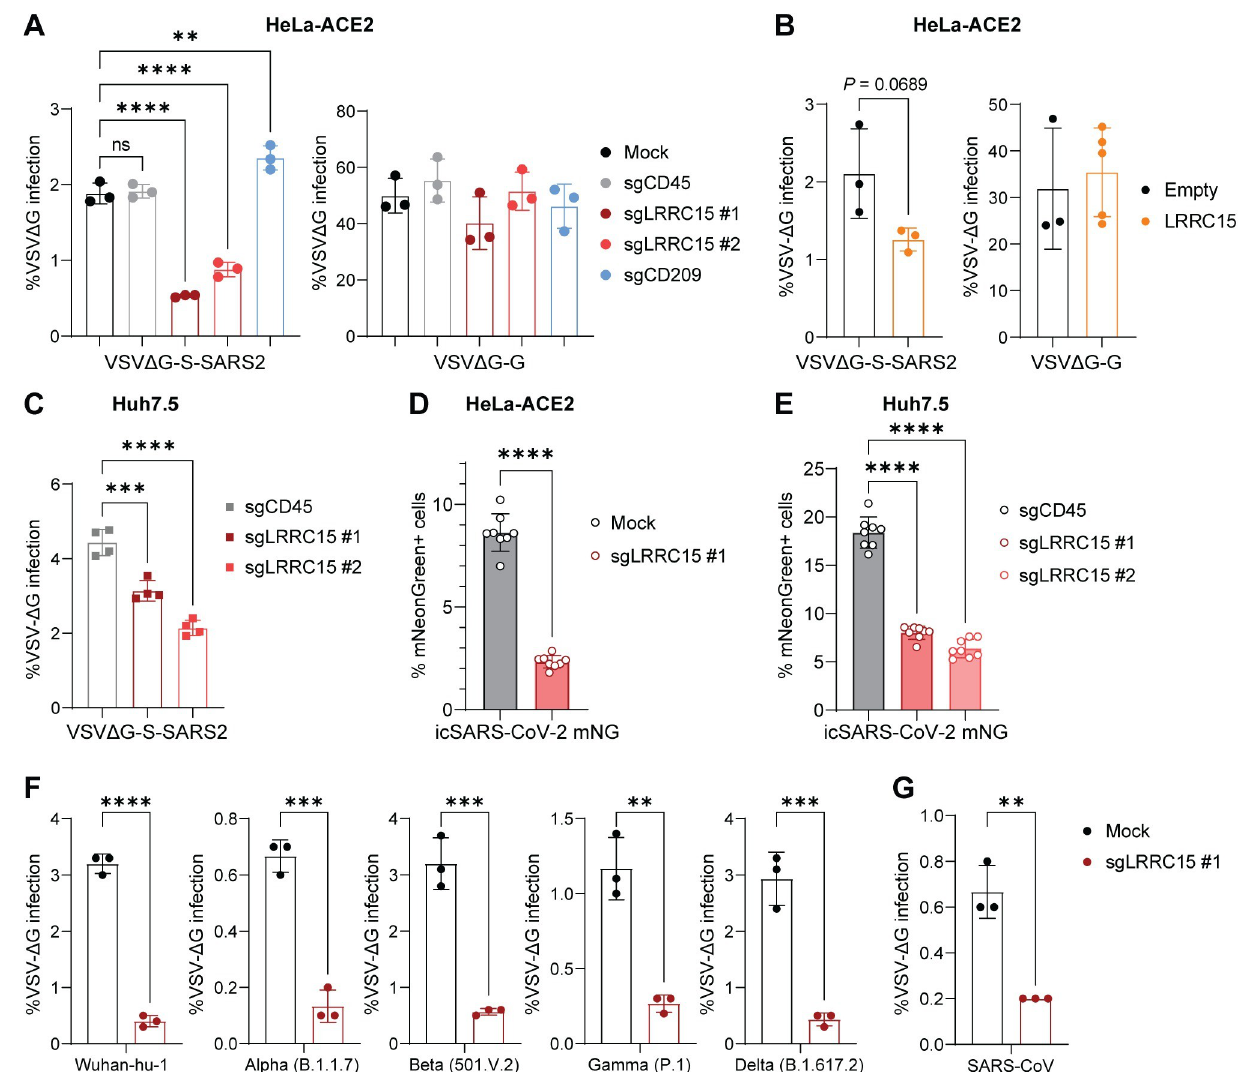
Fig 3. LRRC15 inhibits ACE2-mediated SARS-CoV-2 entry. ( A ) HeLa-ACE2 cells were transduced with indicated activating sgRNAs and infected with VSV pseudoviruses, VSV Δ G-S-SARS2 or VSV Δ G-G. GFP signal was measured at 20 hpi by flow cytometry ( n = 3). Representative of 3 independent experiments are shown. ( B ) HeLa-ACE2 cells expressing LRRC15 or empty vector were infected with VSV psuedoviruses and GFP signal was measured at 20 hpi by flow cytometry ( n = 3). Representative of 3 independent experiments are shown. ( C ) Huh7.5 cells were transduced with indicated activating sgRNAs and infected with VSV Δ G-S-SARS2. GFP signal was measured at 20 hpi by flow cytometry ( n = 4). Representative of 3 independent experiments are shown. ( D , E ) HeLa-ACE2 (D) or Huh7.5 (E) were transduced with indicated activating sgRNAs and infected with icSARS-CoV-2 mNG at 1 MOI. Infected cell frequencies were measured by mNeonGreen expression at 24 hpi ( n = 8). Representative of 2 ( D ) or 3 ( E ) independent experiments are shown. ( F ) LRRC15-induced or mock HeLa-ACE2 cells were infected with VSV pseudoviruses harboring spike proteins of different SARS-CoV-2 variants. GFP signal was measured at 20 hpi by flow cytometry ( n = 3). ( G ) LRRC15-induced or mock HeLa-ACE2 cells were infected with VSV pseudoviruses harboring SARS-CoV-1 spike. GFP signal was measured at 20 hpi by flow cytometry ( n = 3). Data represent means ± SD ( A - G ). Data were analyzed by one-way ANOVA with Dunnett multiple comparisons test ( A , C , E ) or unpaired two-tailed t test ( B , D , F , G ). ns, not significant; � p < 0.05; �� p < 0.01; ��� p < 0.001; ���� p < 0.0001. For underlying data, see S3 Data . ACE2, angiotensin-converting enzyme 2; GFP, green fluorescent protein; hpi, hours postinfection; LRRC15, leucin-rich repeat-containing 15; MOI, multiplicity of infection; SARS-CoV-1, Severe Acute Respiratory Syndrome Coronavirus; SARS-CoV-2, Severe Acute Respiratory Syndrome Coronavirus 2; sgRNA, single guide RNA; VSV, vesicular stomatitis